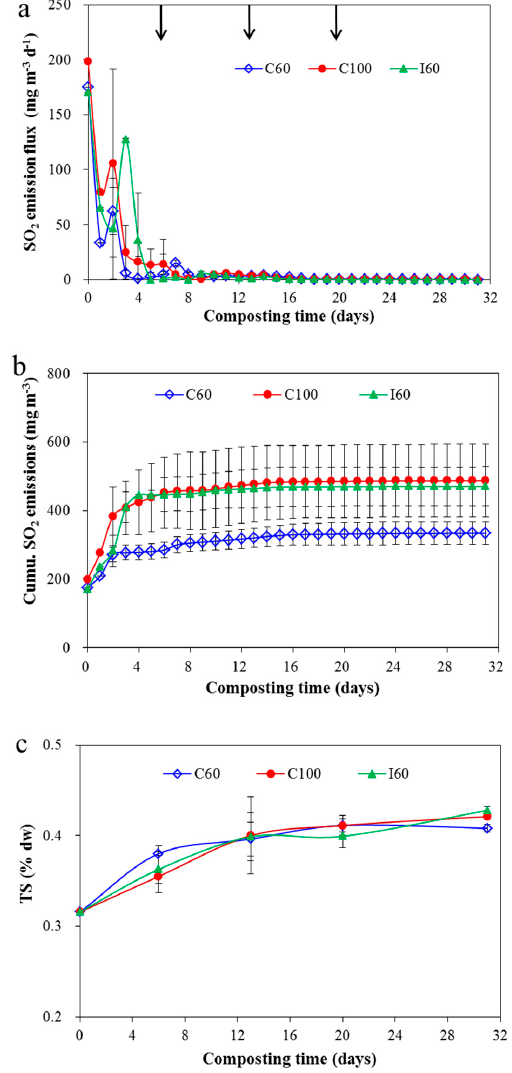
Figure 6. Change of SO 2 ( a ), cumulative SO 2 ( b ) emissions, change of TS ( c ) during composting. Results are the mean of three replicates and error bars indicate standard deviation. Arrows indicate the time of turning. For abbreviations see Figure 1.